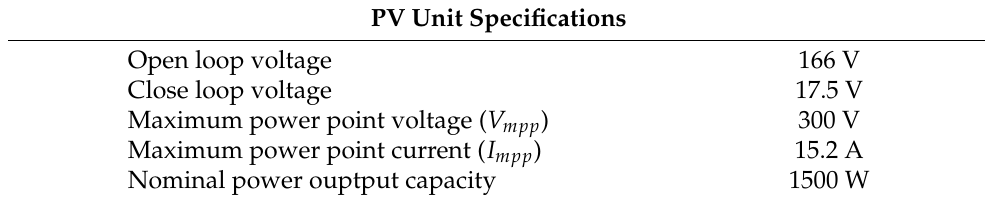
Table 1. Parameters of renewable energy